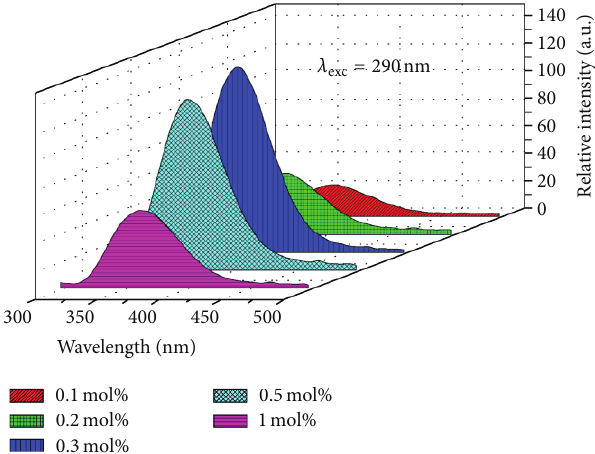
(BO 3 ) 2 ( 𝑥 = 0.001, 3 Figure 5: Variation in emission intensity of ( Ca (1−𝑥) Bi 𝑥 ) = 0.001, 0.002, 0.003, 0.005,